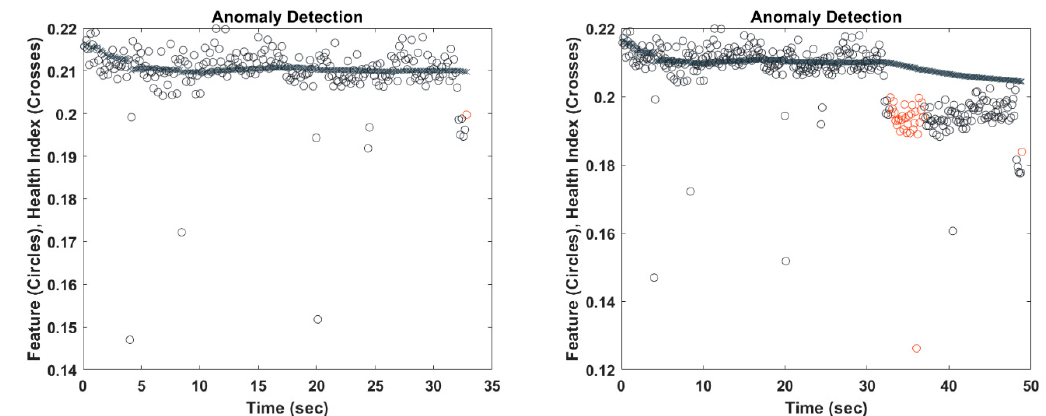
Figure 11. Degradation dataset.